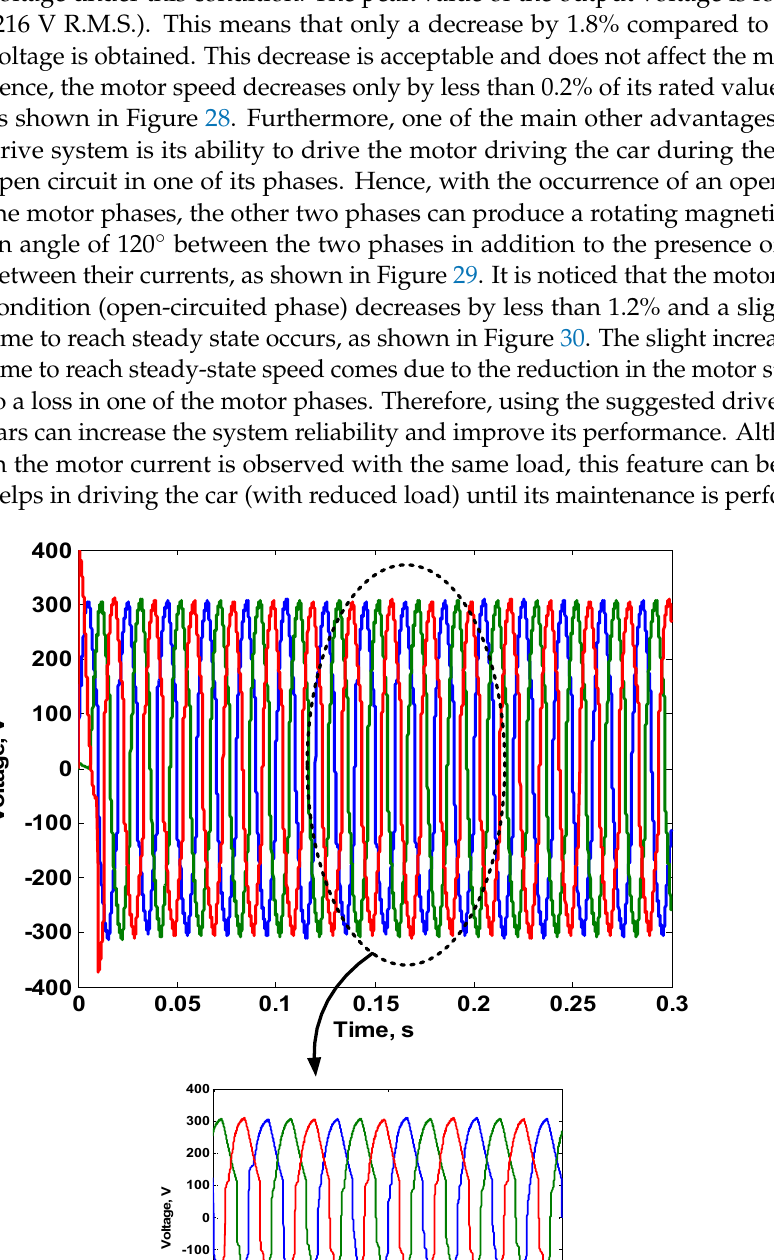
Figure 28. Three-Phase Motor Speed during Two-Battery Failure. 0